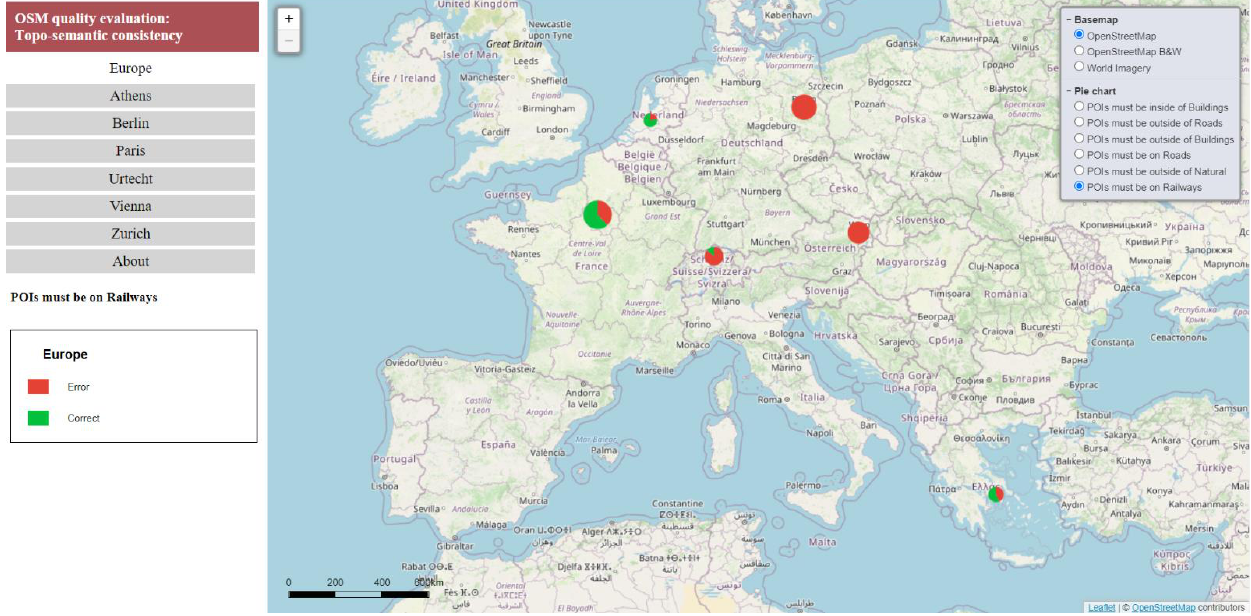
Figure A2. At the regional level, topo-semantic errors for “POIS must on Railways” are portrayed with a pie chart for each city.